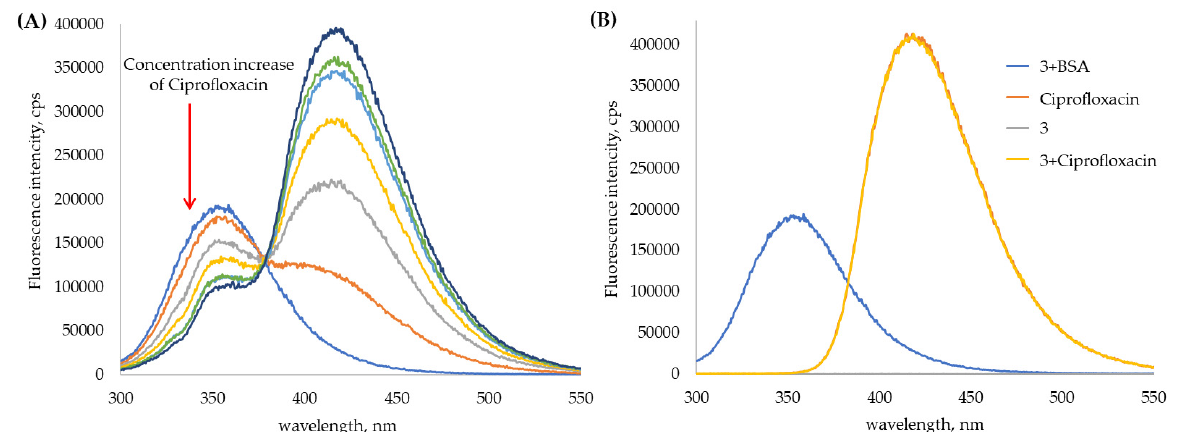
Figure 6. Fluorescence spectra of ( A ) titration of 3 (1 × 10 − 5 M)/BSA (1 × 10 − 5 M) with ciprofloxacin (antibiotic concentration changed from 0 to 5 × 10 − 5 M) ( B ) 3 (1 × 10 − 5 M), ciprofloxacin (4.17 × 10 − 5 M), 3 + BSA system (1/1), 3 + ciprofloxacin system (1/1).